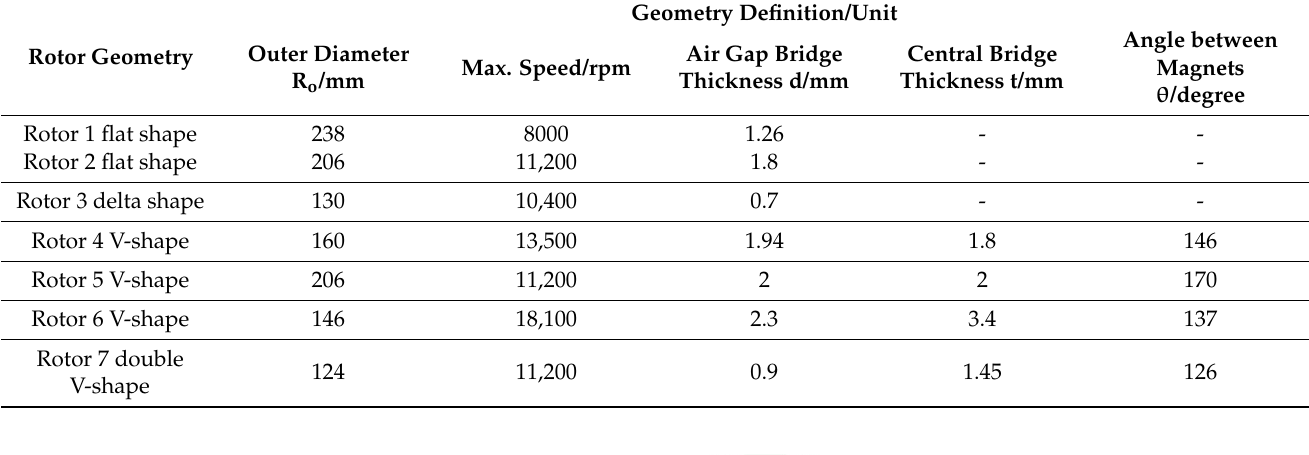
Table 2. Geometries of the investigated rotors.